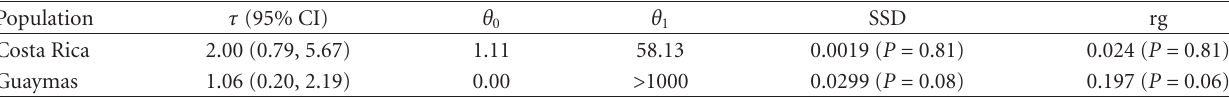
Table 2: Results of the mismatch distribution of COI sequences in Junonia genoveva from Costa Rica ( N = 22) and Guaymas, Mexico ( N = 19).